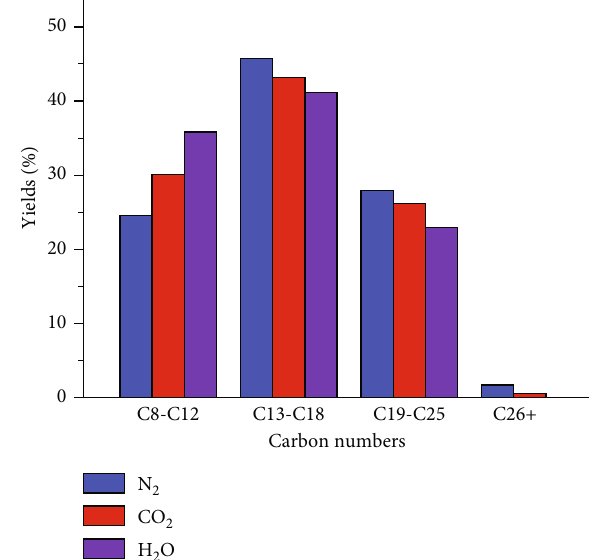
Figure 5: Carbon number distribution of aliphatic hydrocarbons in pyrolysis oil in di ff erent